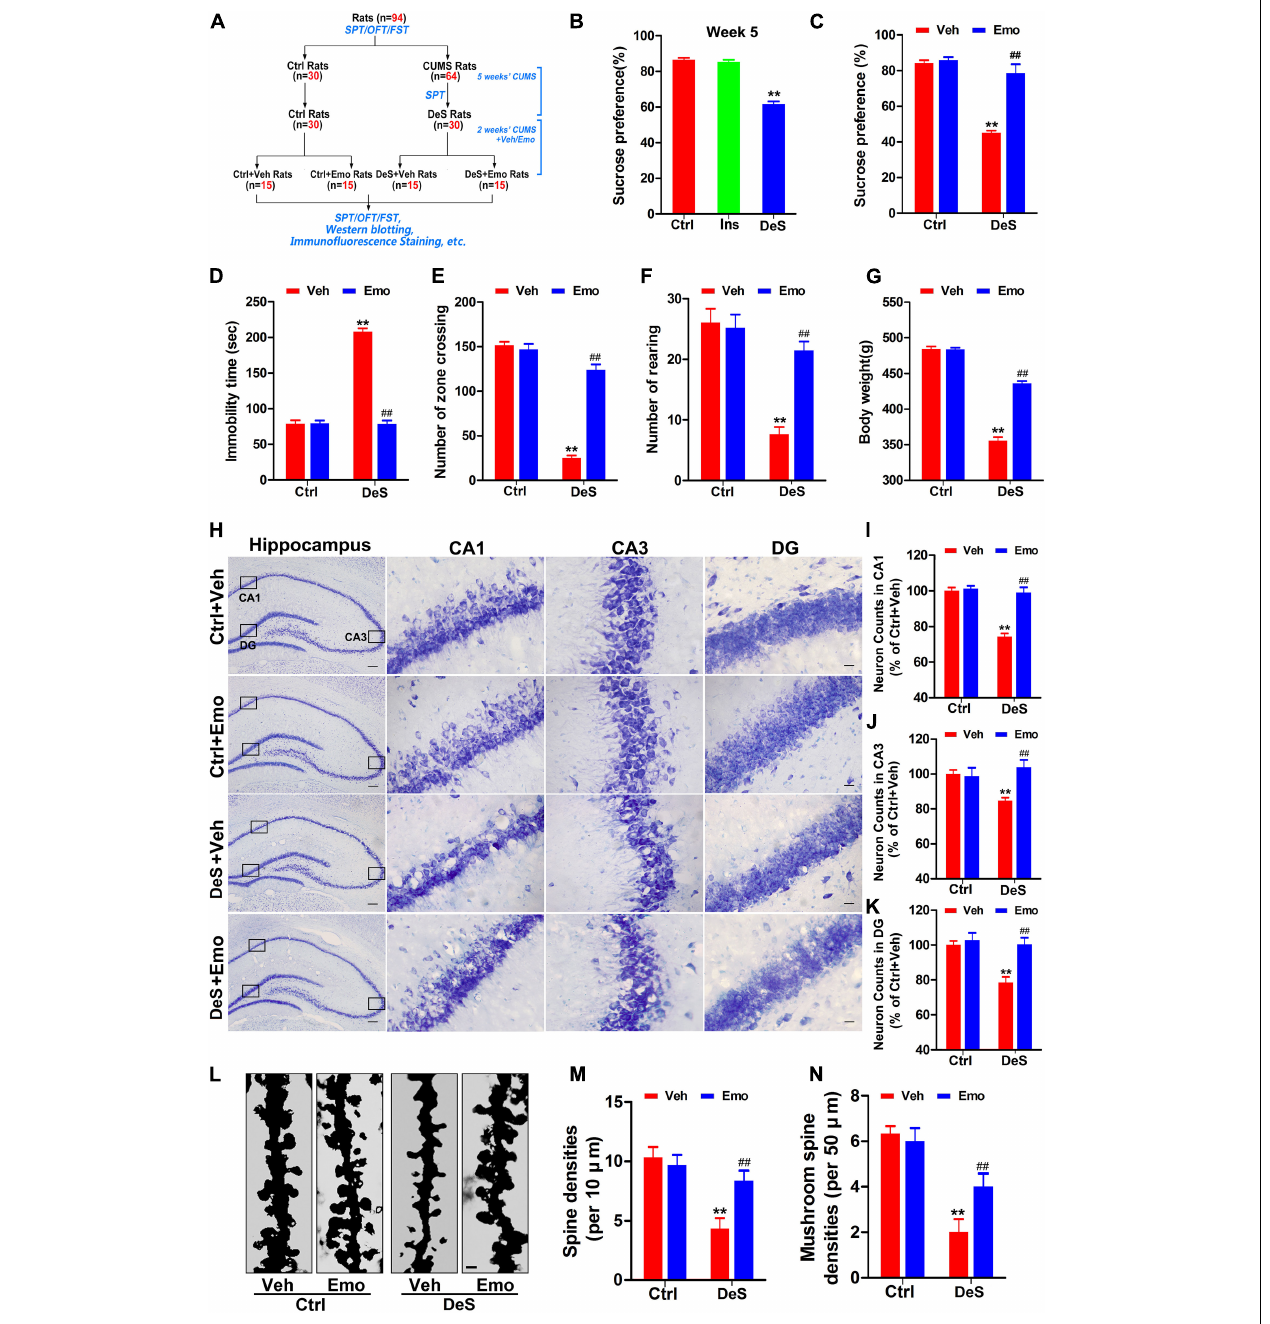
FIGURE 3 | Emodin ameliorated depression-like behaviors in DeS rats. Schematic illustration of the second part of this research (A) . The sucrose preference test (SPT), forced swimming test (FST), and open field test (OFT) were performed as shown. By SPT, we selected 30 depression-susceptible rats (DeS rats) from 64 rats at the end of fifth week (B) [ F ( 2 , 86 ) = 143.894, p = 0.000]. 30 unstressed rats were the control (Ctrl). Then, the DeS and Ctrl rats accepted emodin (Emo) or the same volume of solvent (Veh) treatment. The Emo treated (DeS + Emo) and Veh treated DeS rats (DeS + Veh) were continuously exposed to CUMS. Finally, the sucrose preference rates in the SPT (C) [ F ( 3 , 56 ) = 48.668, p = 0.000], immobility time in the FST (D) [ F ( 3 , 56 ) = 255.939, p = 0.000], numbers of zone crossing (E) [ F ( 3 , 56 ) = 153.596, p = 0.000] and rearing times (F) [ F ( 3 , 56 ) = 25.595, p = 0.000] in the OFT, and the body weights (G) [ F ( 3 , 56 ) = 307.749, p = 0.000] were recorded ( n = 15/group). Hippocampal neurons were shown by Nissl staining ( H , left scale bar = 200 µ m, right scale bar = 20 µ m) and quantified in CA1 (I) [ F ( 3 , 8 ) = 36.35, p = 0.000], CA3 (J) [ F ( 3 , 8 ) = 10.681, p = 0.004], and DG (K) [ F ( 3 , 8 ) = 10.862, p = 0.003] regions ( n = 3 brains/group). The dendrites of CA1 neurons were shown by Golgi staining ( L , n = 3 brains/group, scale bar = 1 µ m). Quantifications of the densities of spine (M) [ F ( 3 , 8 ) = 9.286, p = 0.006] and mushroom-type spine (N) [ F ( 3 , 8 ) = 14.500, p = 0.001] were calculated by Image-Pro Plus 6.0 software ( n = 21 dendrites from 3 brains/group). Data were analyzed by one-way ANOVA with LSD post hoc test and presented as means ± S.E.M. ** p < 0.01 DeS + Veh versus Ctrl + Veh, ## p < 0.01 DeS + Emo versus DeS + Veh.